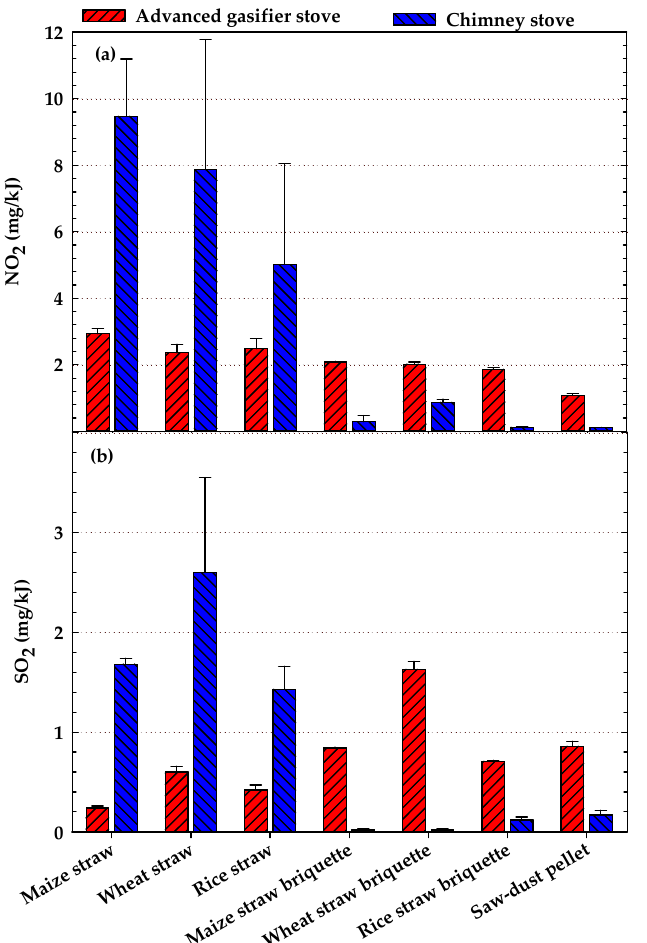
Figure 4. ( a ) NO 2 EFs and ( b ) SO 2 EFs for raw crop straws, biomass briquettes, and pellets burned in the advanced biomass gasifier cooking stove and the chimney cooking stove.